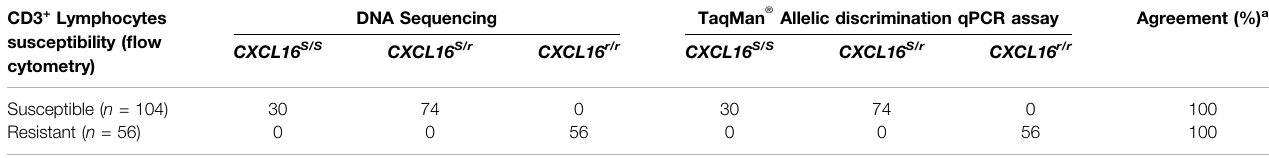
TABLE 1 | Determination of CXCL16 genotypes by DNA sequencing and TaqMan ® allelic discrimination qPCR assay and phenotyping via fl ow cytometric analysis of EAV- infected PBMCs ( n = 160). CD3 + Lymphocytes